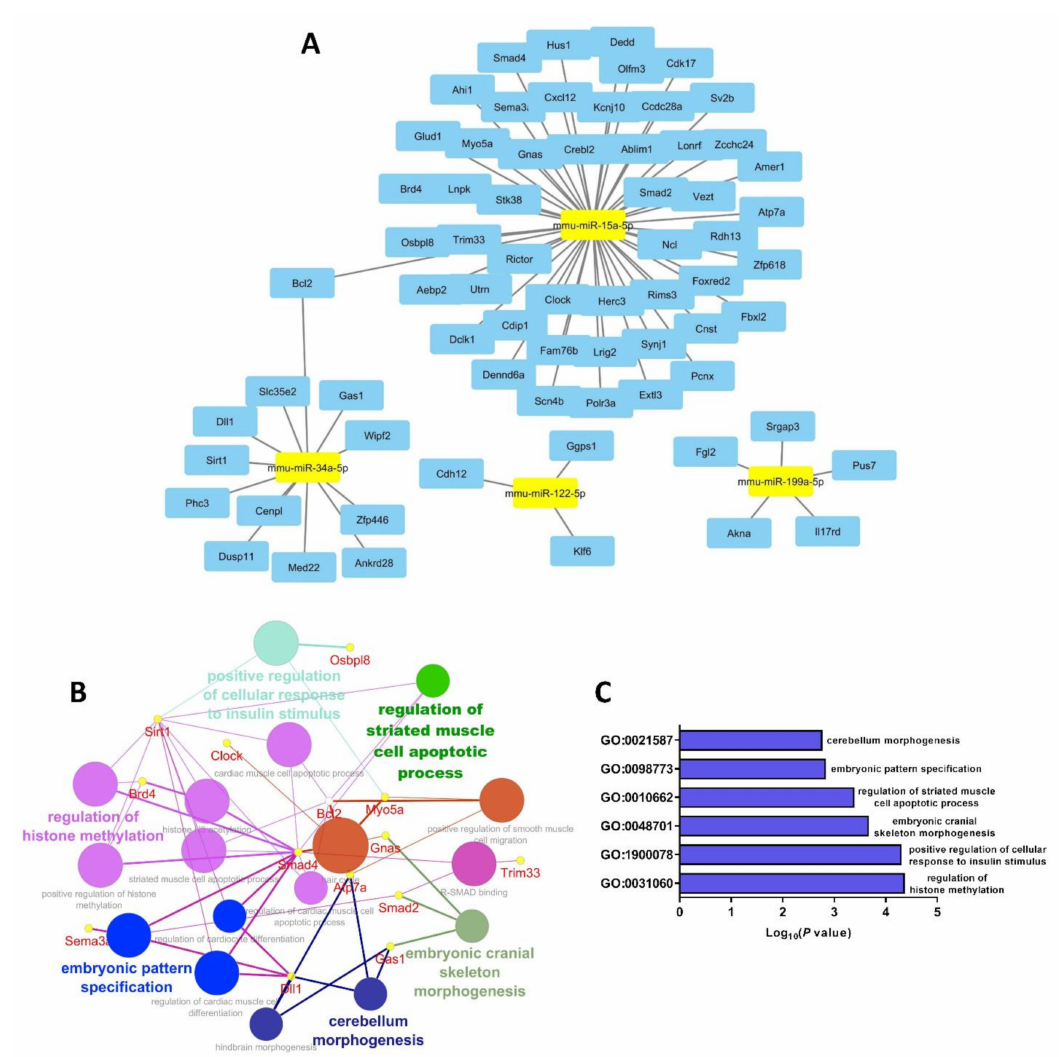
Figure 5. Bioinformatic network of selected miRs predicted gene targets. Target analysis of miR-15a, -34a, -199a and -122 by Cytoscape showed numerous (70) predicted gene targets ( A ). KEGG pathway analysis of the 70 predicted genes indicated that they could interact with each other forming a molecular network that can regulate significant as well as diverse developmental processes. Small circles represent a range of p value of 1.5–1.7 × 10 − 3 , moderate circles 2.2–4.2 × 10 − 5 and large circles 4.4–5.1 × 10 − 5 after Bonferroni correction ( B ). The most significant GO showing statistical significance were cerebellum morphogenesis, embryonic pattern specification, regulation of striated muscle cell apoptotic process, embryonic cranial skeleton morphogenesis, positive regulation of cellular response to insulin stimulus and regulation of histone methylation ( C